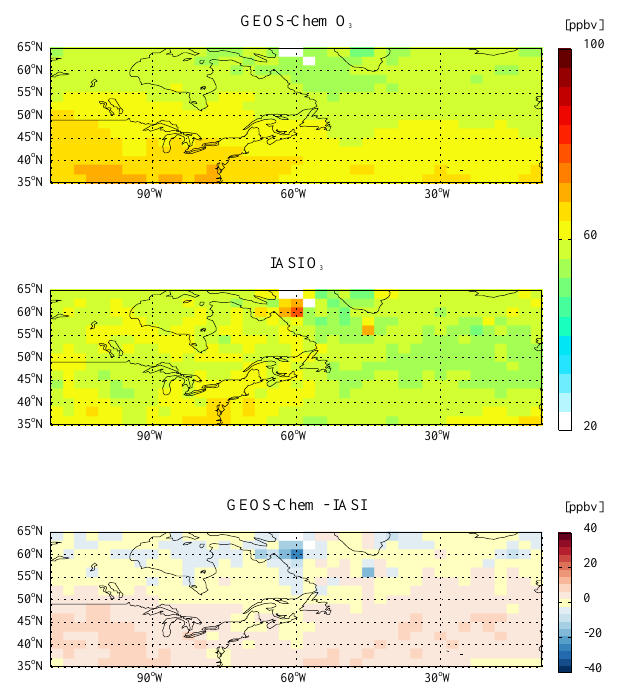
Fig. 8. Same as Fig. 7 for the ozone distribution observed by the Infrared Atmospheric Sounding Instrument, and the model ozone profiles have been smoothed by the IASI averaging kernels and the IASI bias has been